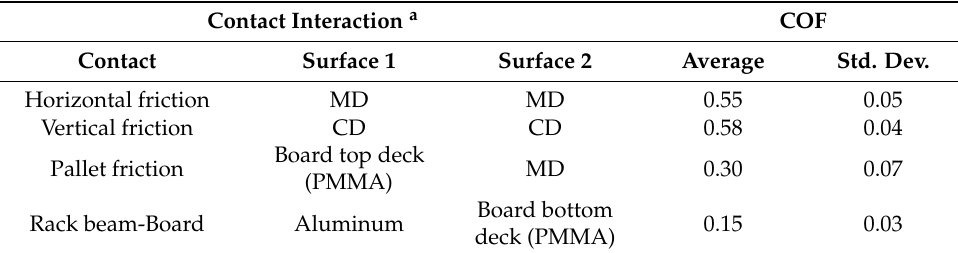
Table 3. Coefficients of friction for each contact condition in the unit load simulator, obtained according to TAPPI T-815 [46], with an average of 10 replicates per contact interaction.